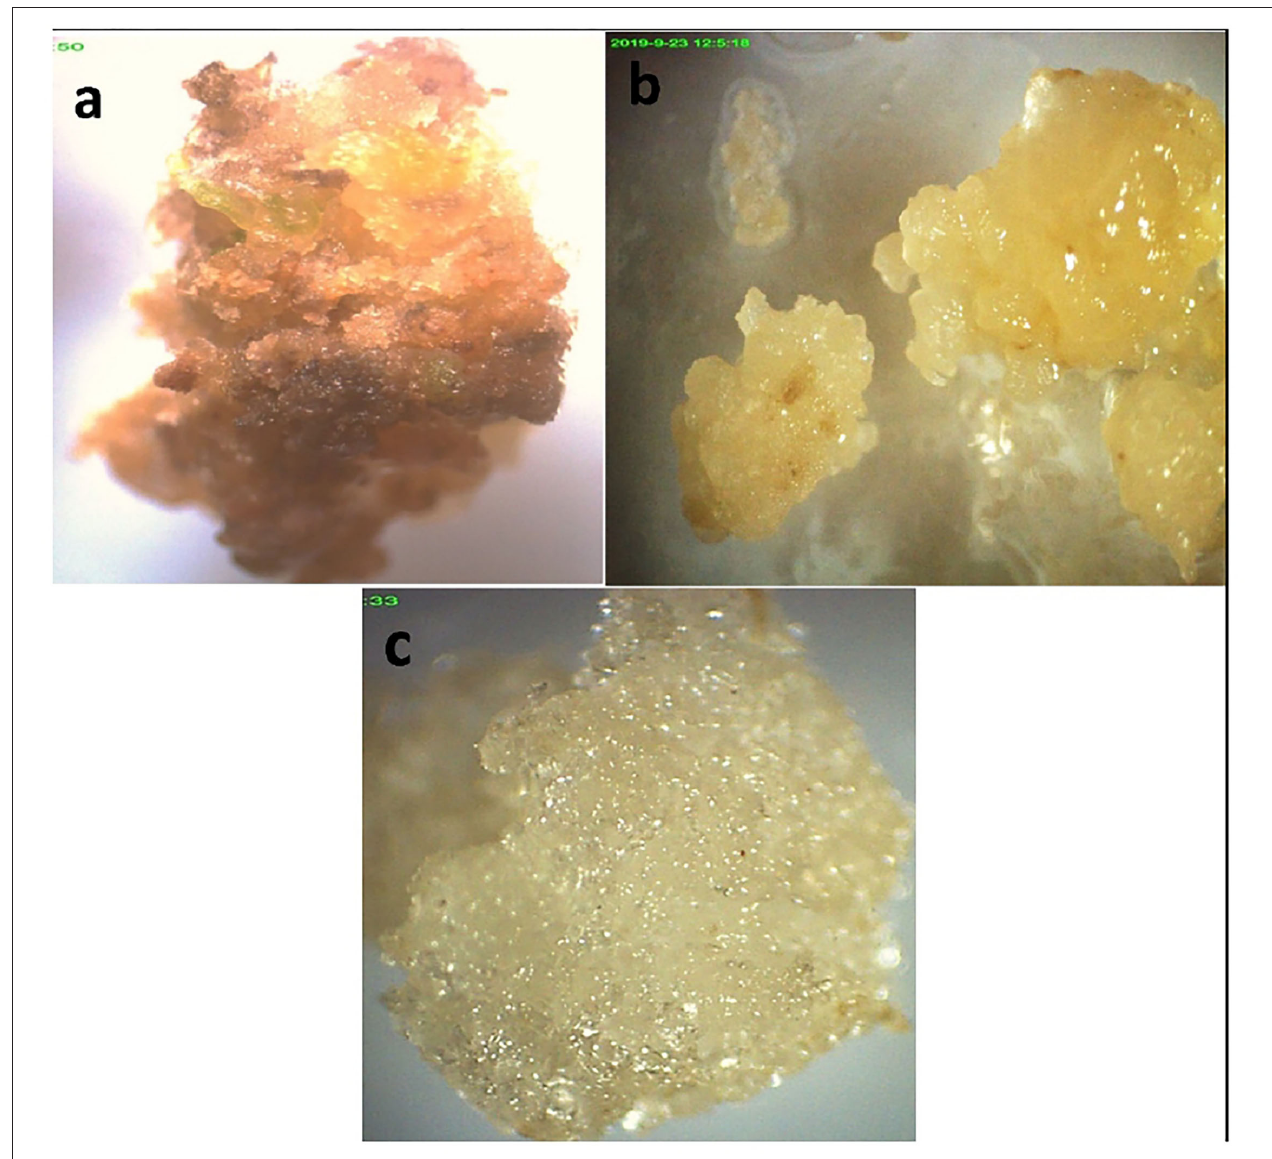
FIGURE 4 | Callus culture establishment of three varieties of mung bean in MS + 2,4-D 3 mg/L (a) variety 1; (b) variety 3; (c) variety